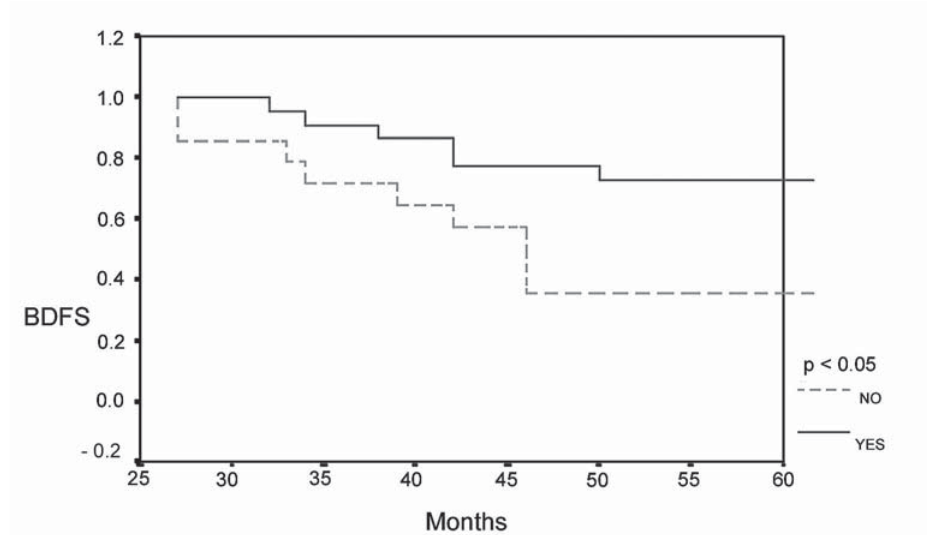
Figure 3 – Five years biochemical disease free survival (BDFS) for the combination of brachytherapy with external beam radiotherapy.